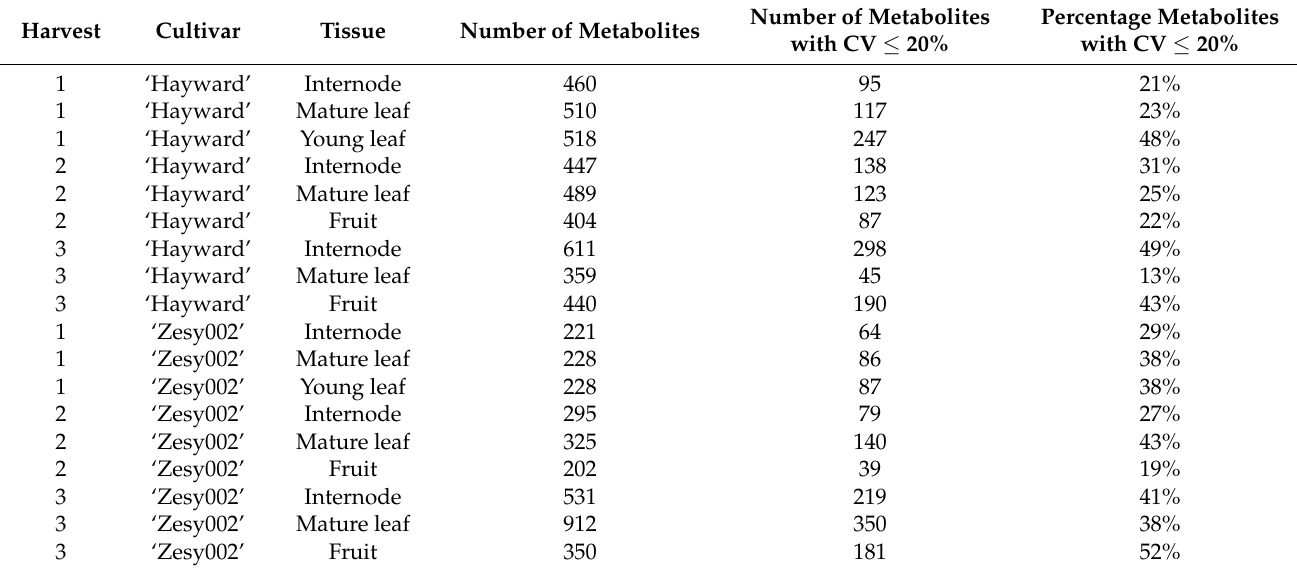
Table 2. Numbers of metabolites (mass tags) measured, and numbers and percentages of metabolites with CV less than 20%, measured in ‘Hayward’ and ‘Zesy002’ internode, and mature leaf issue and fruit samples at three harvest